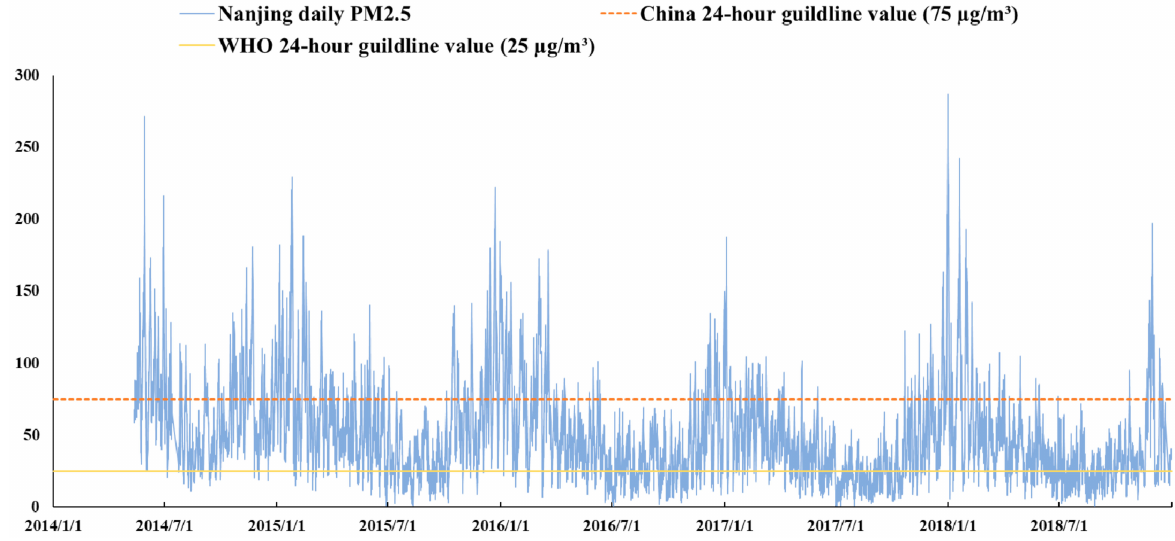
Figure 1. The daily change of Nanjing Particulate Matter (PM 2.5 ) concentration ( µ g/m 3 ). Notes: Data come from 9 monitors within Nanjing, as these monitors had been established before 2014, their number and locations do not change over